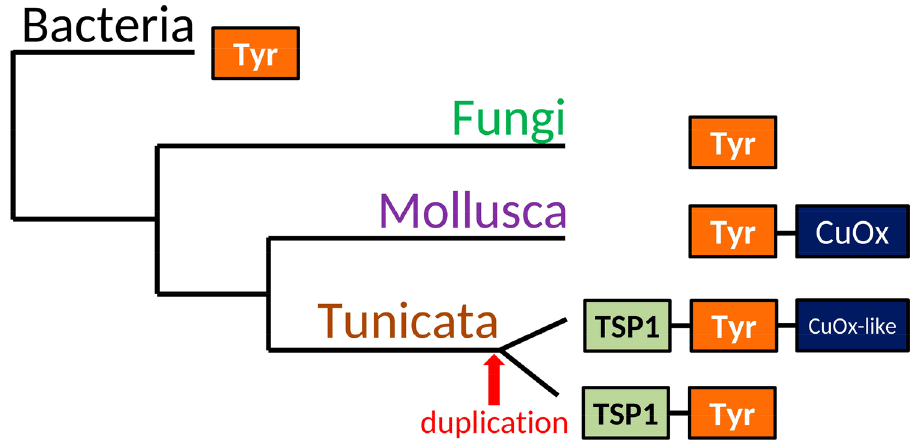
Figure 8. Schematic representation of domain composition in alfa tyrosinases belonging to different taxonomic groups. TSP1 thrombospondin first type repeat, Tyr tyrosinase, CuOx domain of cupredoxin